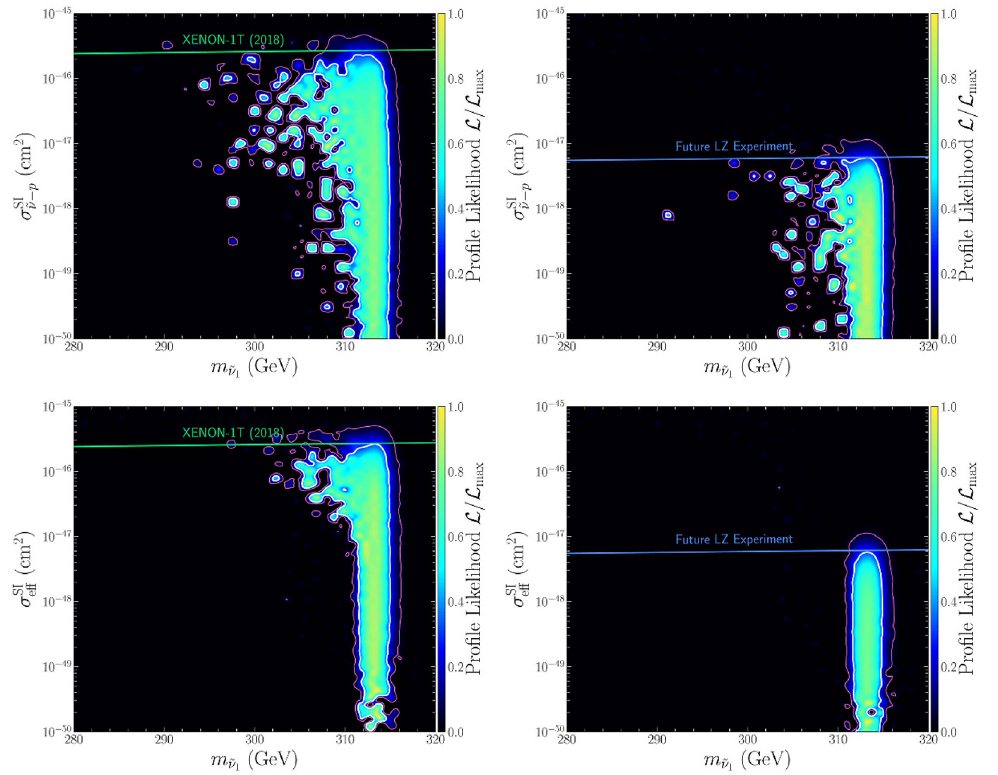
Figure 7 . Same as figure 2, but for the massive h s scenario defined in table